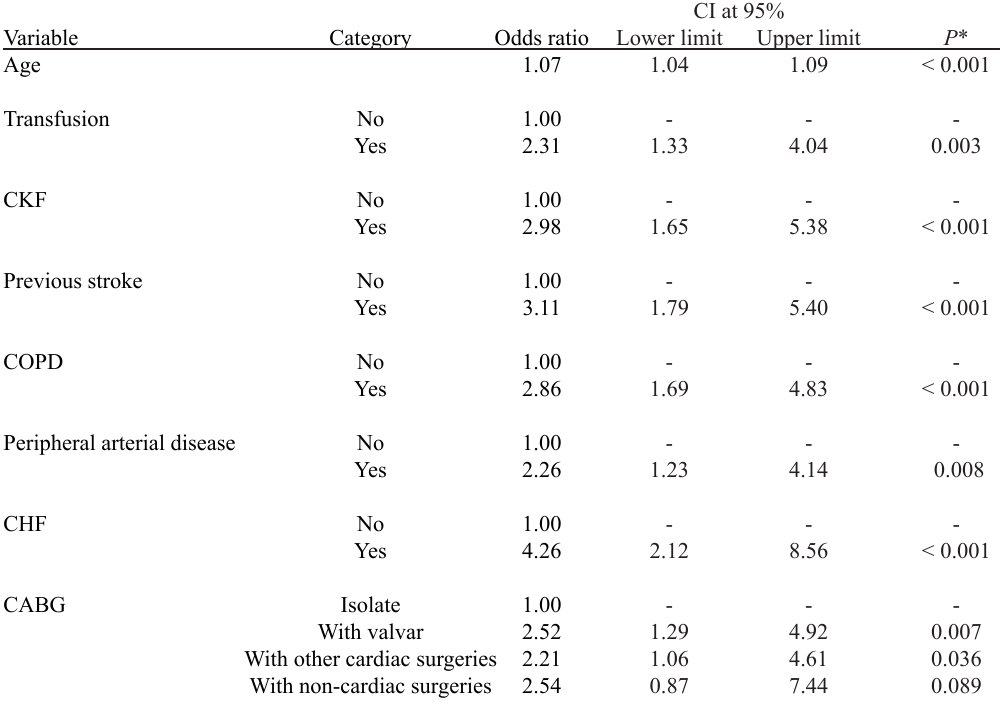
Table 2. Odds ratio values for the associated variables to 1 year